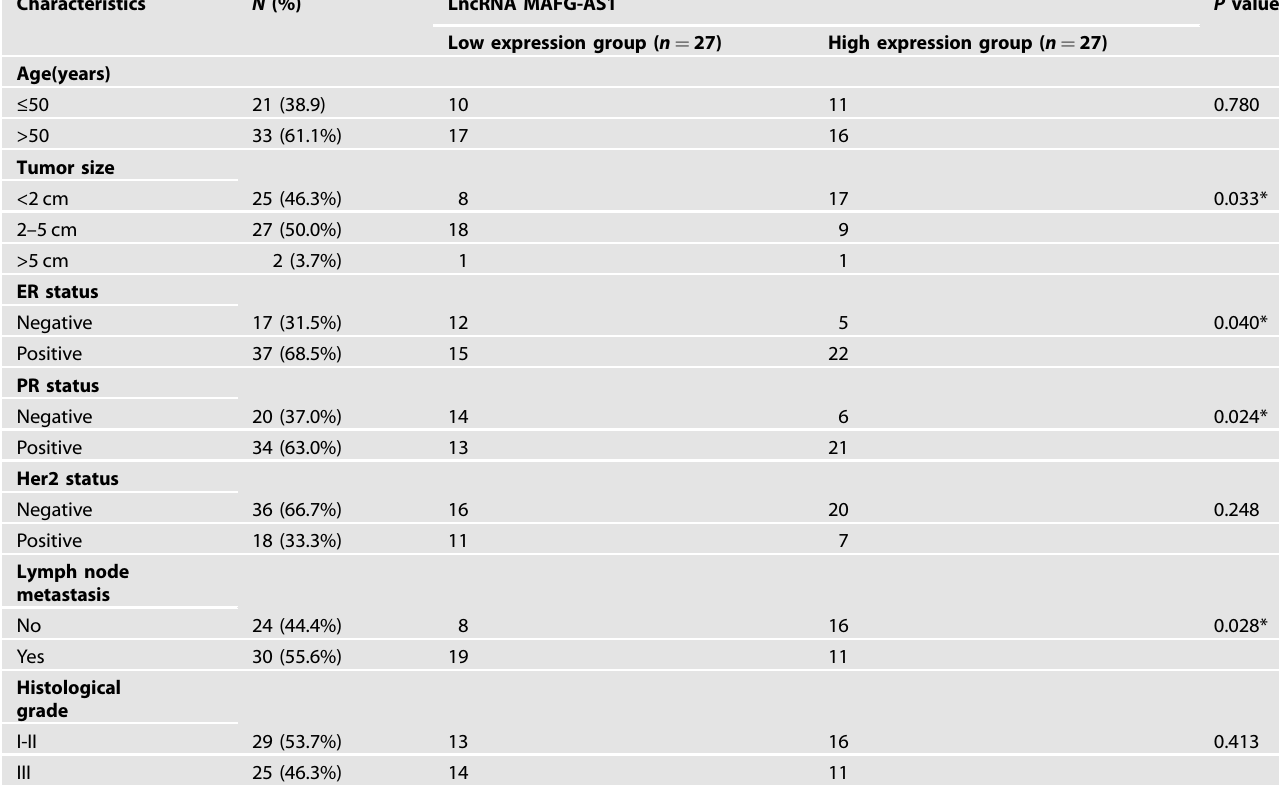
Table 1. Correlation between LncRNA MAFG-AS1 expression and clinicopathological characteristics of BC patients ( n = 54).